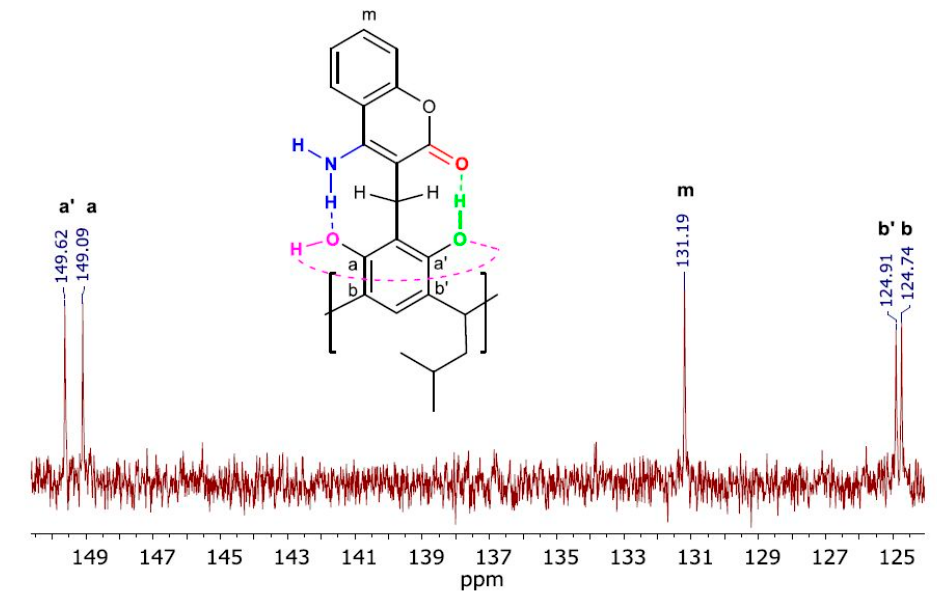
Figure 4. An expansion of the 13 C NMR spectrum (400 MHz, CDCl 3 , 298 K) of derivative 3 , displaying